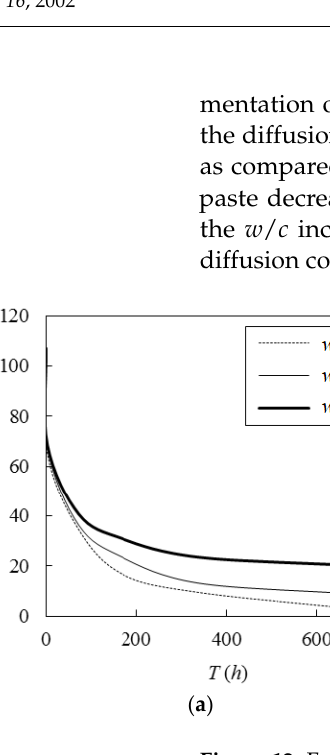
Figure 12. Factors affecting the chloride diffusivity of cement paste: ( a ) effect of curing age; ( b ) effect of curing temperature.